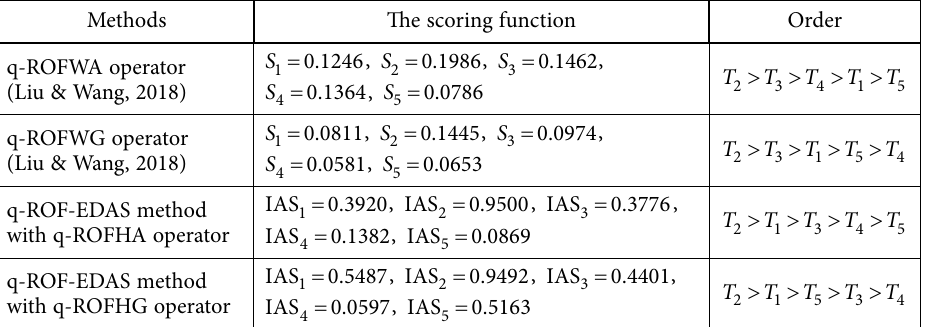
Table 12. Ranking of alternatives by the some operators